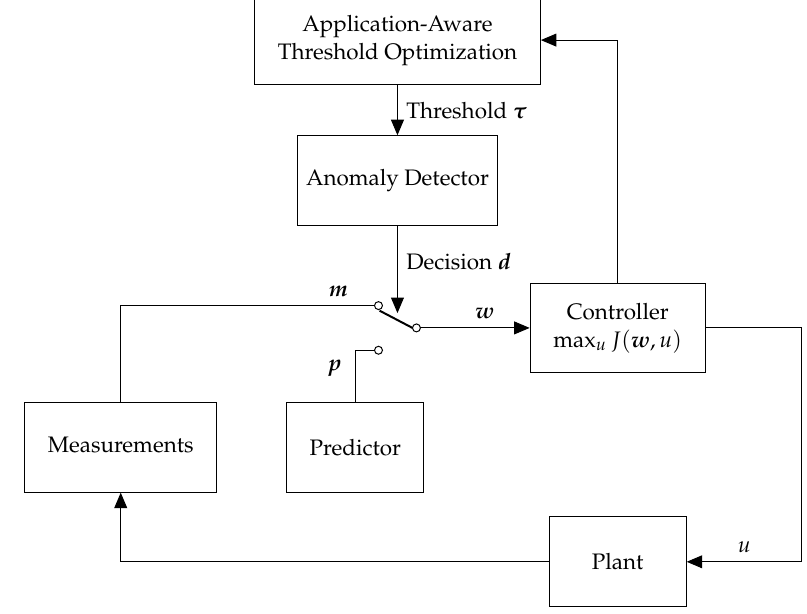
Figure 3. Architecture of Application-Aware Anomaly